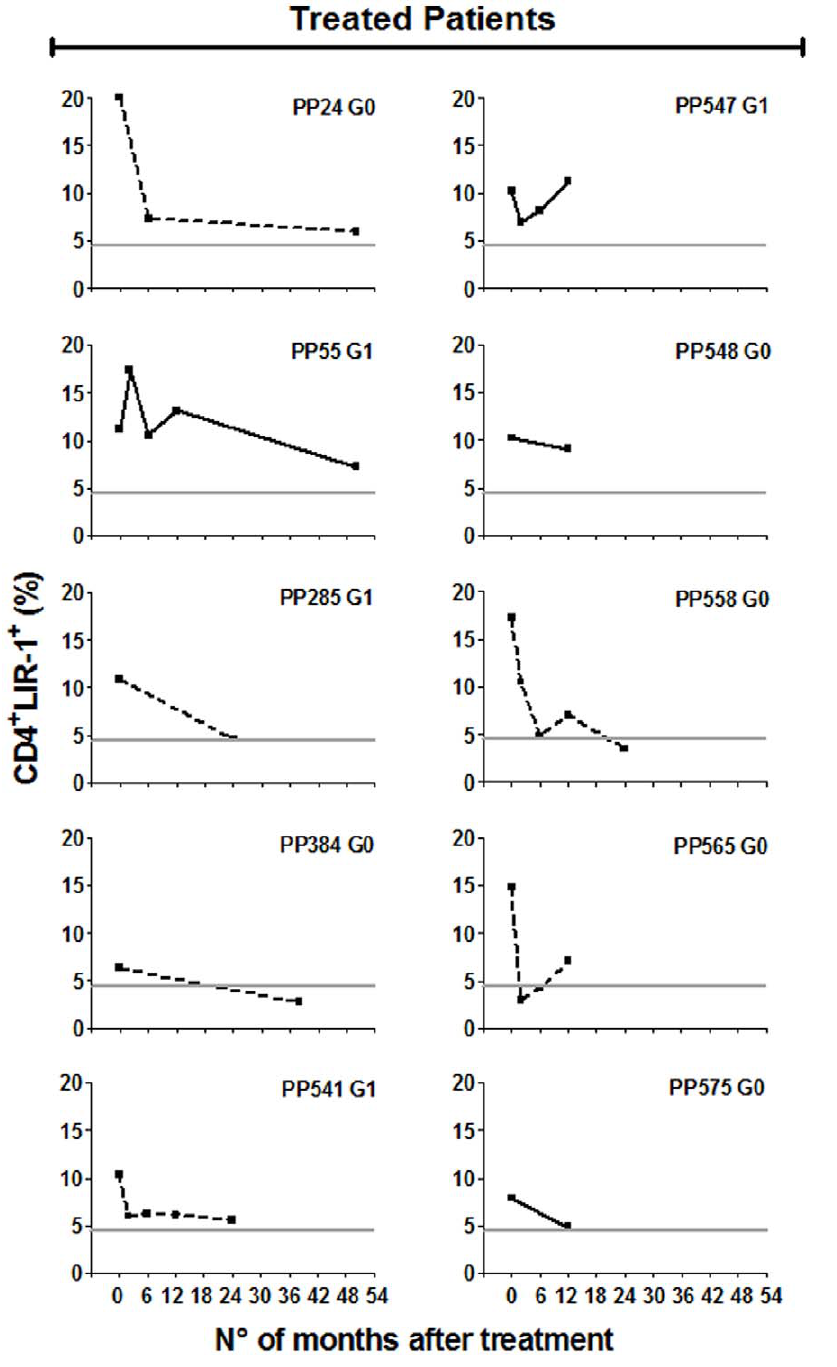
Figure 4. CD4 + T cells expressing LIR-1 following treatment with benznidazole in subjects with increased CD4 + LIR-1 + T cells at baseline. PBMCs from T. cruzi -infected subjects were taken prior and at different time points following treatment with benznidazole and stained with anti-CD4 and anti-LIR-1 monoclonal antibodies. Plots show representative data for single subjects from 10 chronically infected subjects. Significant changes in the levels of CD4 + LIR-1 + T cells, as defined in Materials and Methods are depicted with dotted lines. Horizontal line , cut-off CD4 + LIR-1 + T cell levels in the normal range, as defined in Material and Methods.